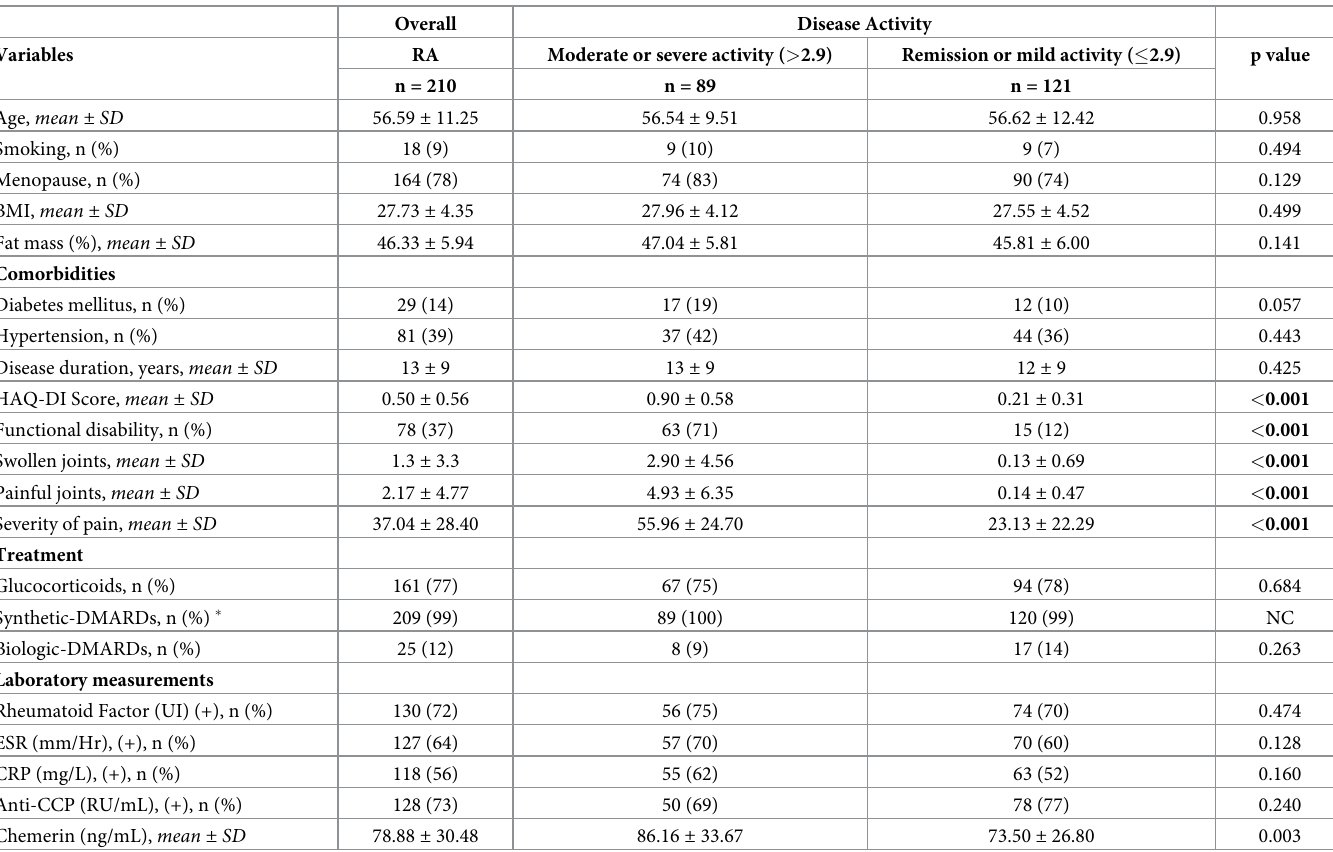
Table 1. Comparison of clinical characteristics between rheumatoid arthritis patients with remission or mild activity and those with moderate or severe activity.